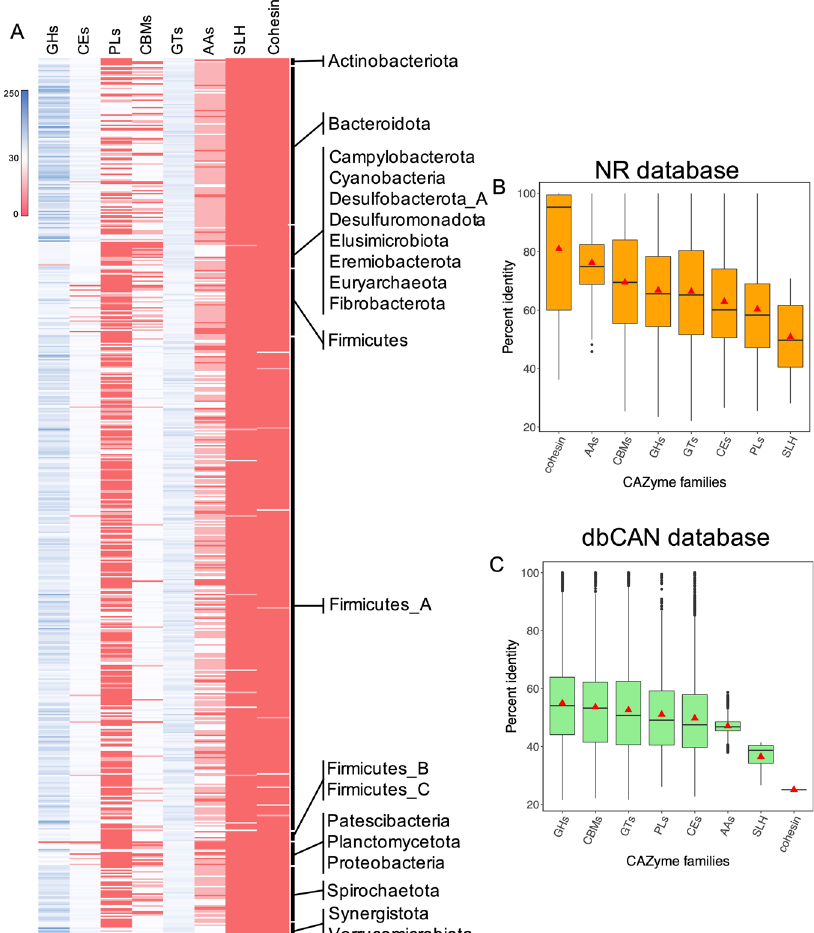
Fig. 4 The pro fi le of carbohydrate active enzymes (CAZymes) predicted in the RUIs and their sequence comparison with public databases. Heatmap shows the abundance pro fi le of CAZymes in RUIs classi fi ed at the phylum level ( A ). The sequences of the predicted CAZymes were searched against non-redundant (nr) protein database ( B ) and dbCAN database ( C ). GHs, glycoside hydrolases; GTs, glycosyl transferases; PLs, polysaccharide lyases; CEs, carbohydrate esterases; AAs, auxiliary activities; and CBs, carbohydrate binding modules. The boxes represent the median (center line) and interquartile ranges, red triangle represents mean and whiskers extend to one and a half times of the interquartile